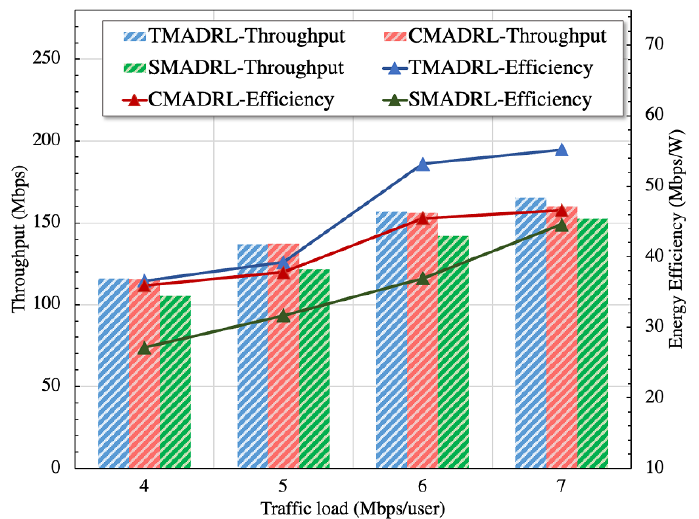
Figure 6. Average energy efficiency ( E e ) and throughput performance metrics for the TMADRL, CMADRL and CMADRL schemes for 4, 5, 6 and 7 Mbps traffic load per